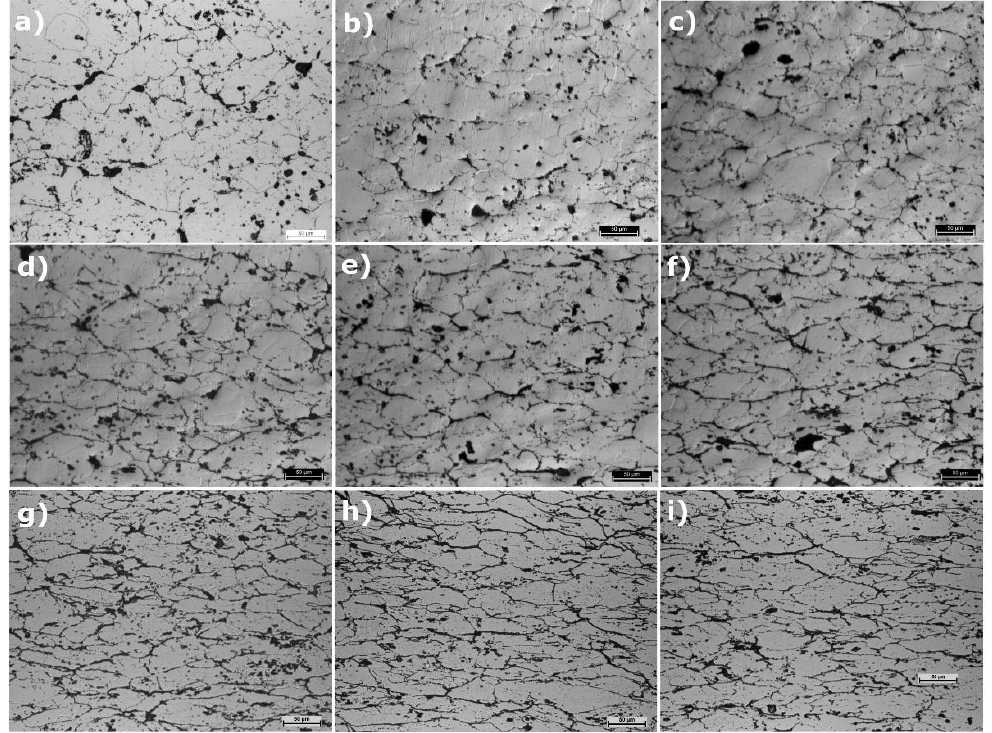
Figure 7. Microstructures of the specimens after deformation (in all cases, the marker length is 50 mm): ( a ) 0%, ( b ) 5%, ( c ) 10%, ( d ) 15%, ( e ) 20%, ( f ) 25%, ( g ) 30%, ( h ) 35%, and ( i ) 40%. Table 4. Mechanical properties of specimens during the tension and compression tests.